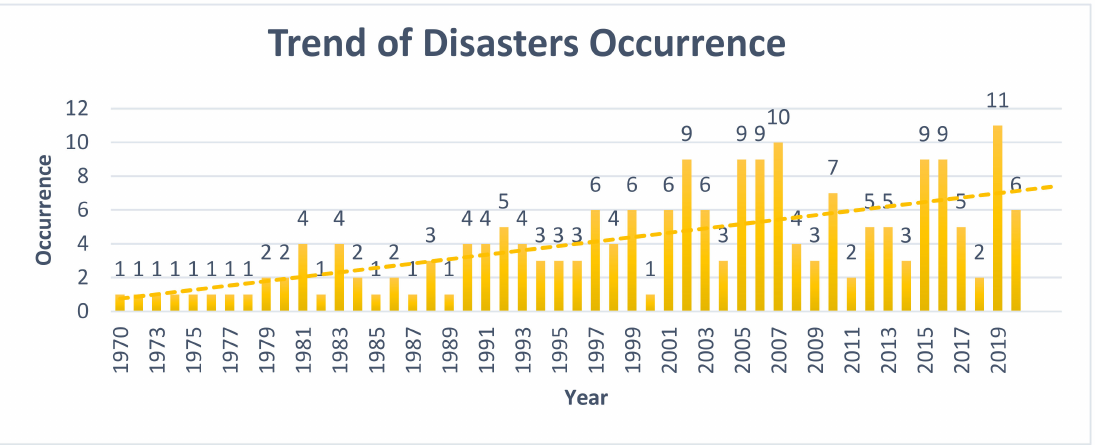
Figure 13. Trend of Disasters Occurrence in Pakistan from 1970–2020; Source: EM-DAT 2020, NDMA. Note: Disasters include those triggered by meteorological, climatological, hydrological, and geophys- ical forces.